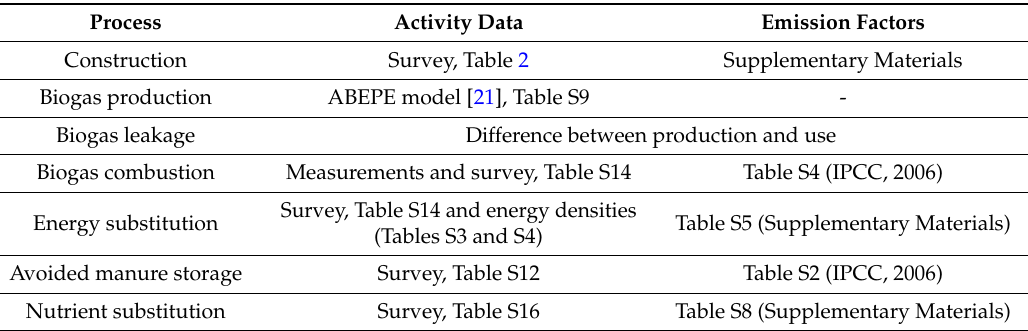
Table 1. Overview of activity data and emission factors used to calculate the net GHG balance of RHB systems, using empirical survey data from biogas and non-biogas households.